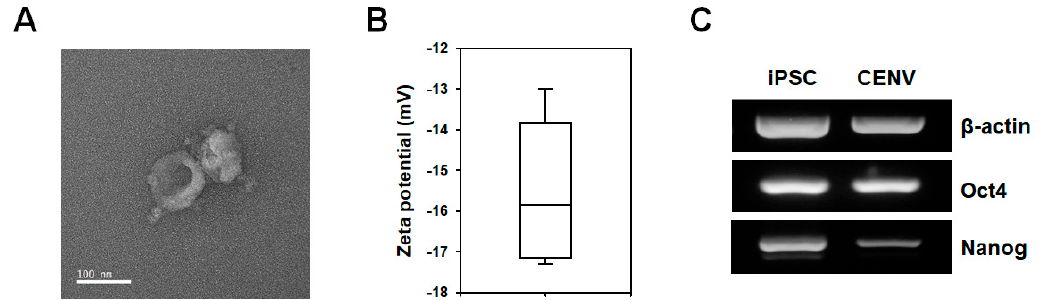
Figure 2. Characterization of iPSC-CENV. ( A ) Transmission electron microscopy (TEM) image of iPSC-CNEV (scale bar = 100 nm). ( B ) Dynamic light scattering (DLS) data of iPSC-CENVs. The mean value of zeta potential was − 15.8 mV. ( C ) Reverse transcriptase polymerase chain reaction (RT-PCR) analysis of iPSCs and iPSC-CENVs for housekeeping gene ( β -actin) and pluripotency-specific genes (Oct4, Nanog).